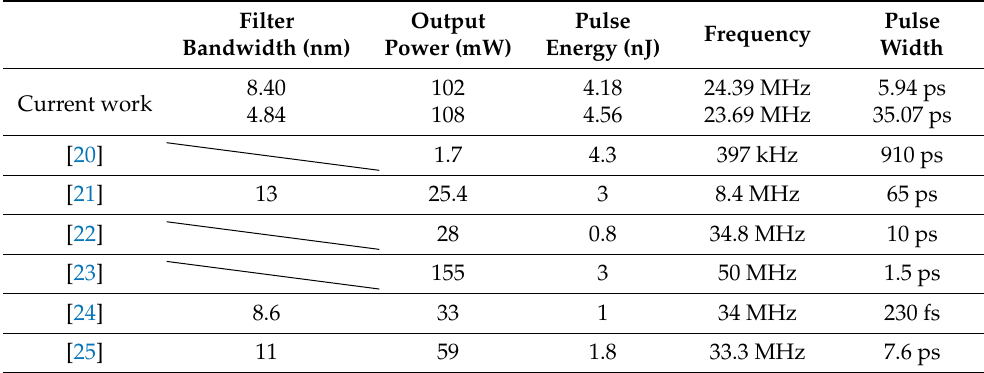
Table 1. Comparison of this work with literature data.